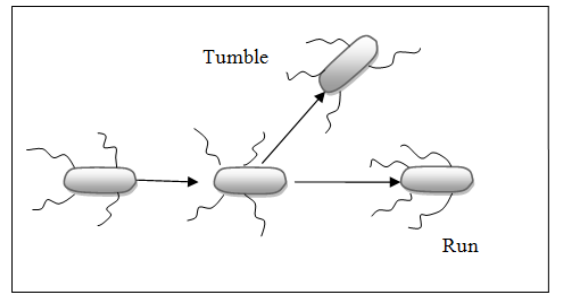
Fig. 1. Chemotactic behavior of E. coli: run and